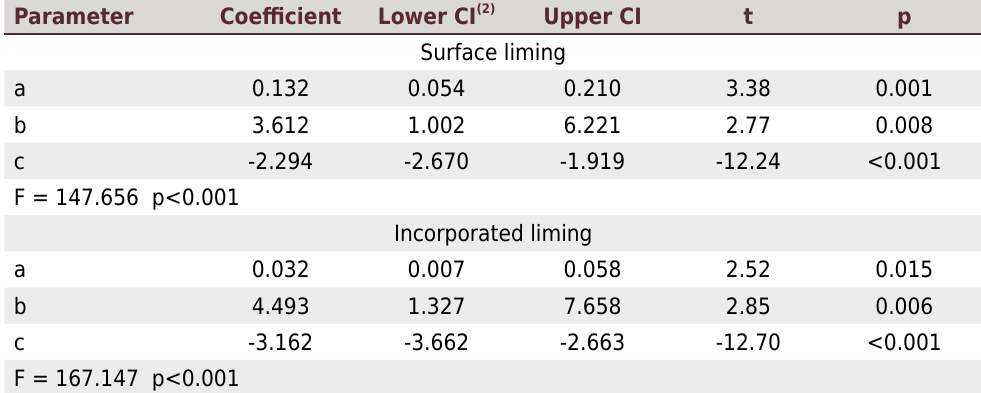
Table 2. Estimators of the parameters of equation of soil penetration resistance (RP) (1)